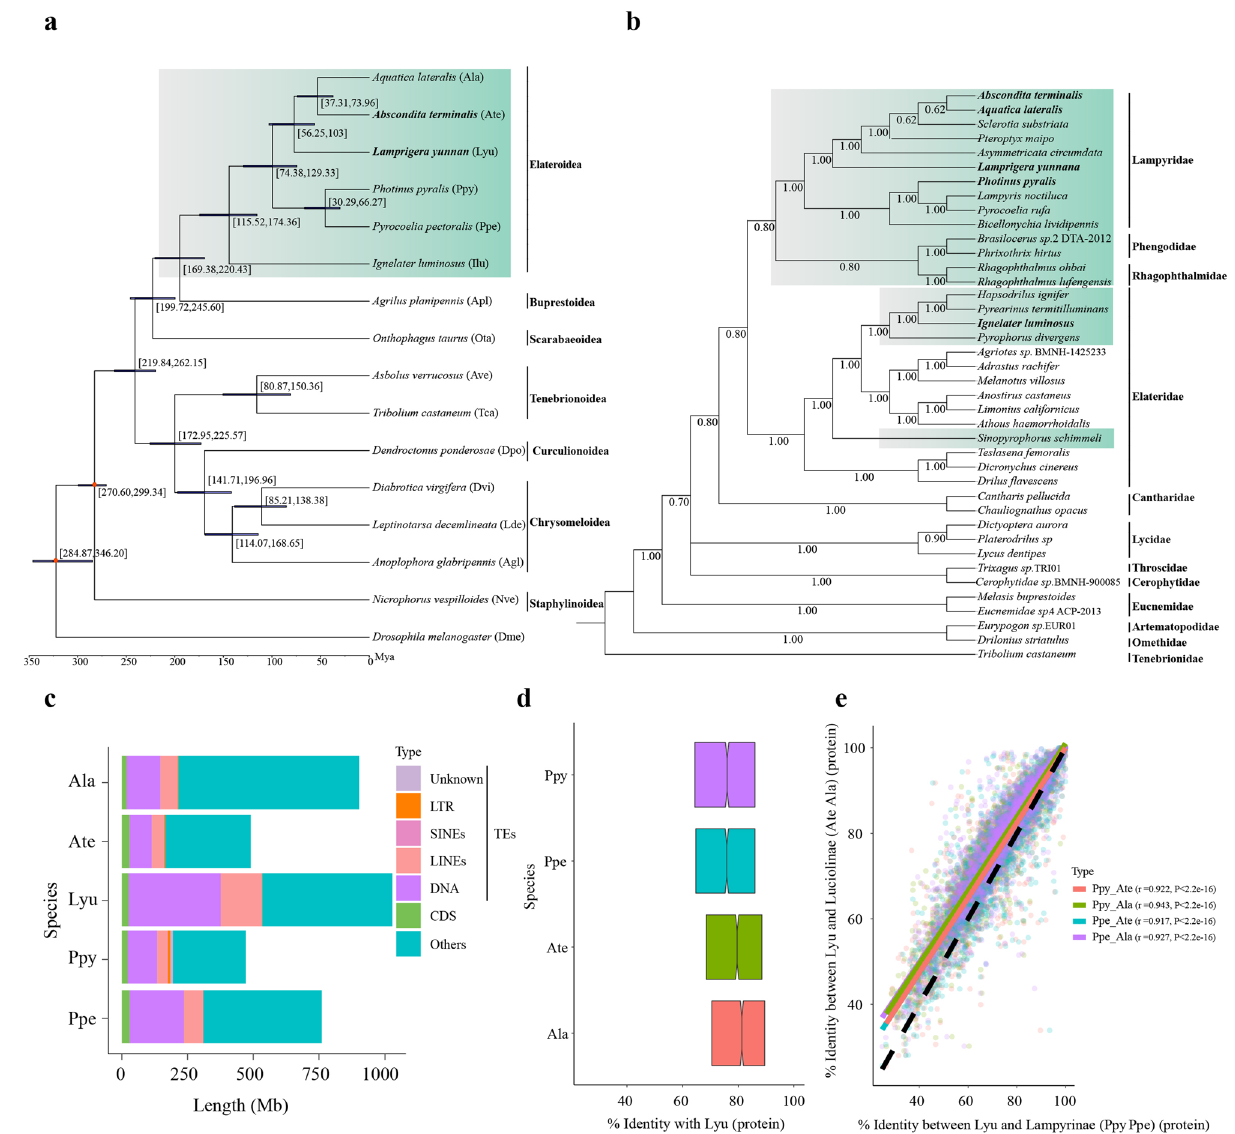
regression, and slope ratio of 1,